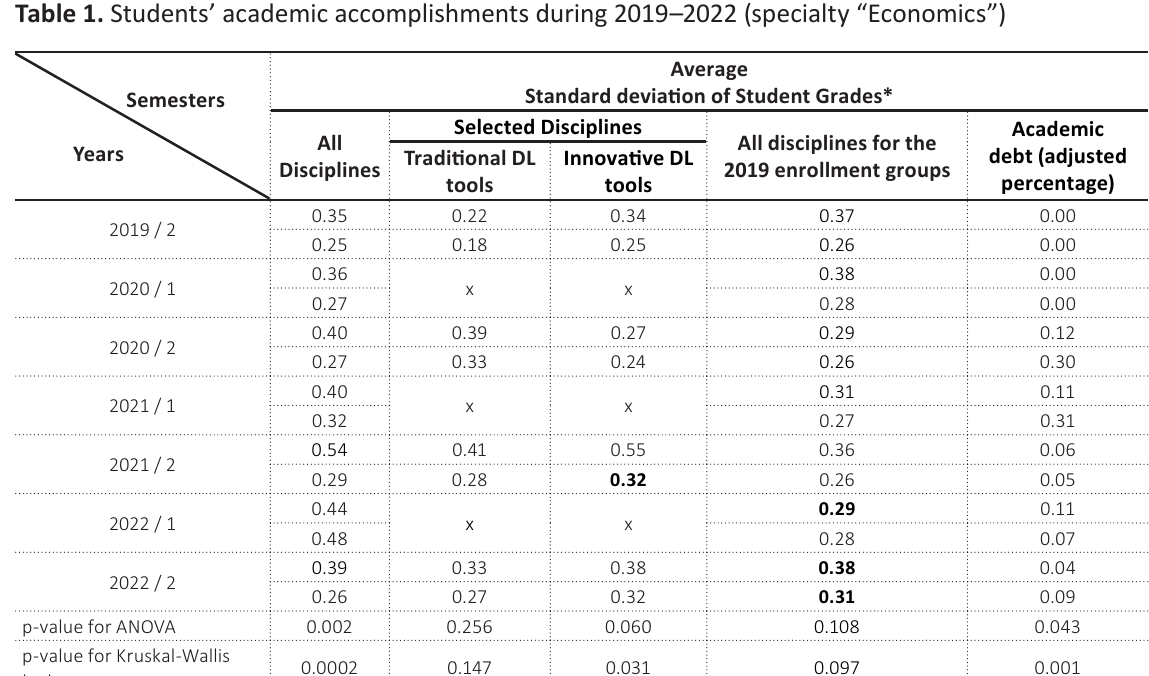
Table 1. Students’ academic accomplishments during 2019–2022 (specialty